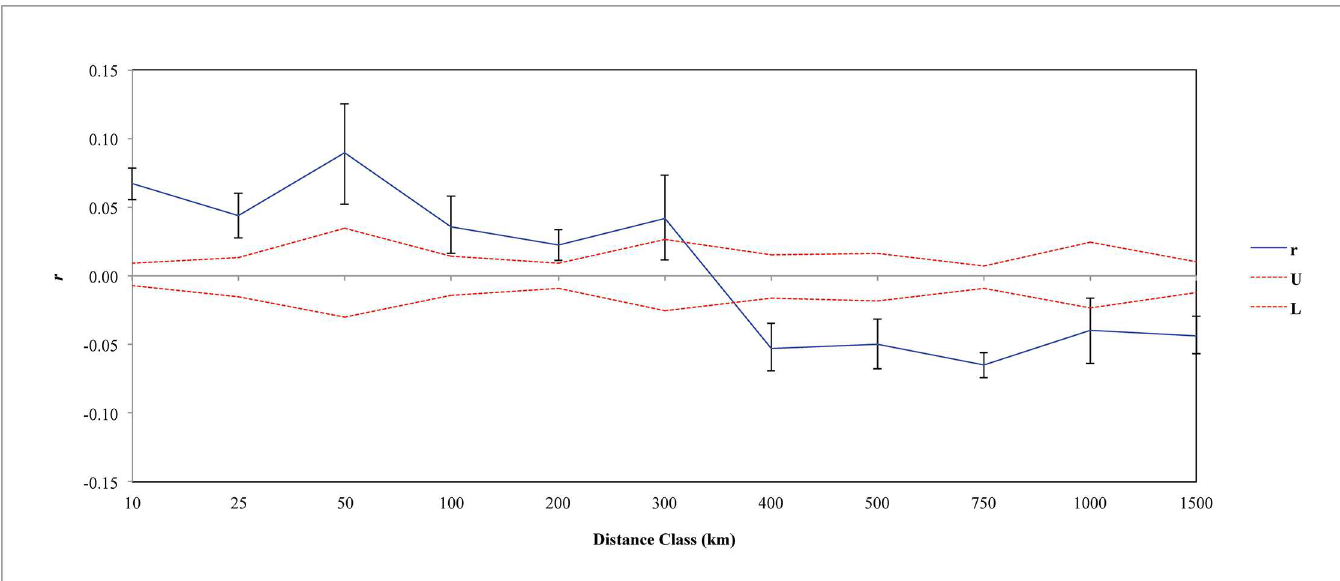
Fig 7. Spatial autocorrelation in Mesoamerican jaguars. Spatial correlogram for jaguars( n = 99) showingthe genetic correlationcoefficient ( r ) as a function of geographic distance across definedspatial distance classes. Dashed red lines represent upper (U) and lower (L) bounds of the null hypothesis of no spatial structure based on 10,000 random permutations. Error bars represent 95% confidence intervals about r based on 1,000